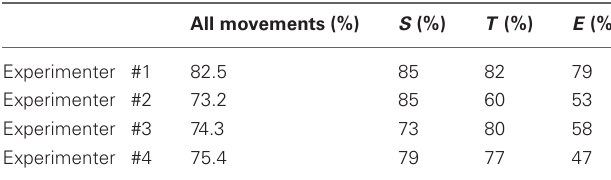
tail-bending angle over time for each maneuver. (Aiii–Ciii) Plots of the curvature of the tail as a function of time and position along the rostro-caudal body